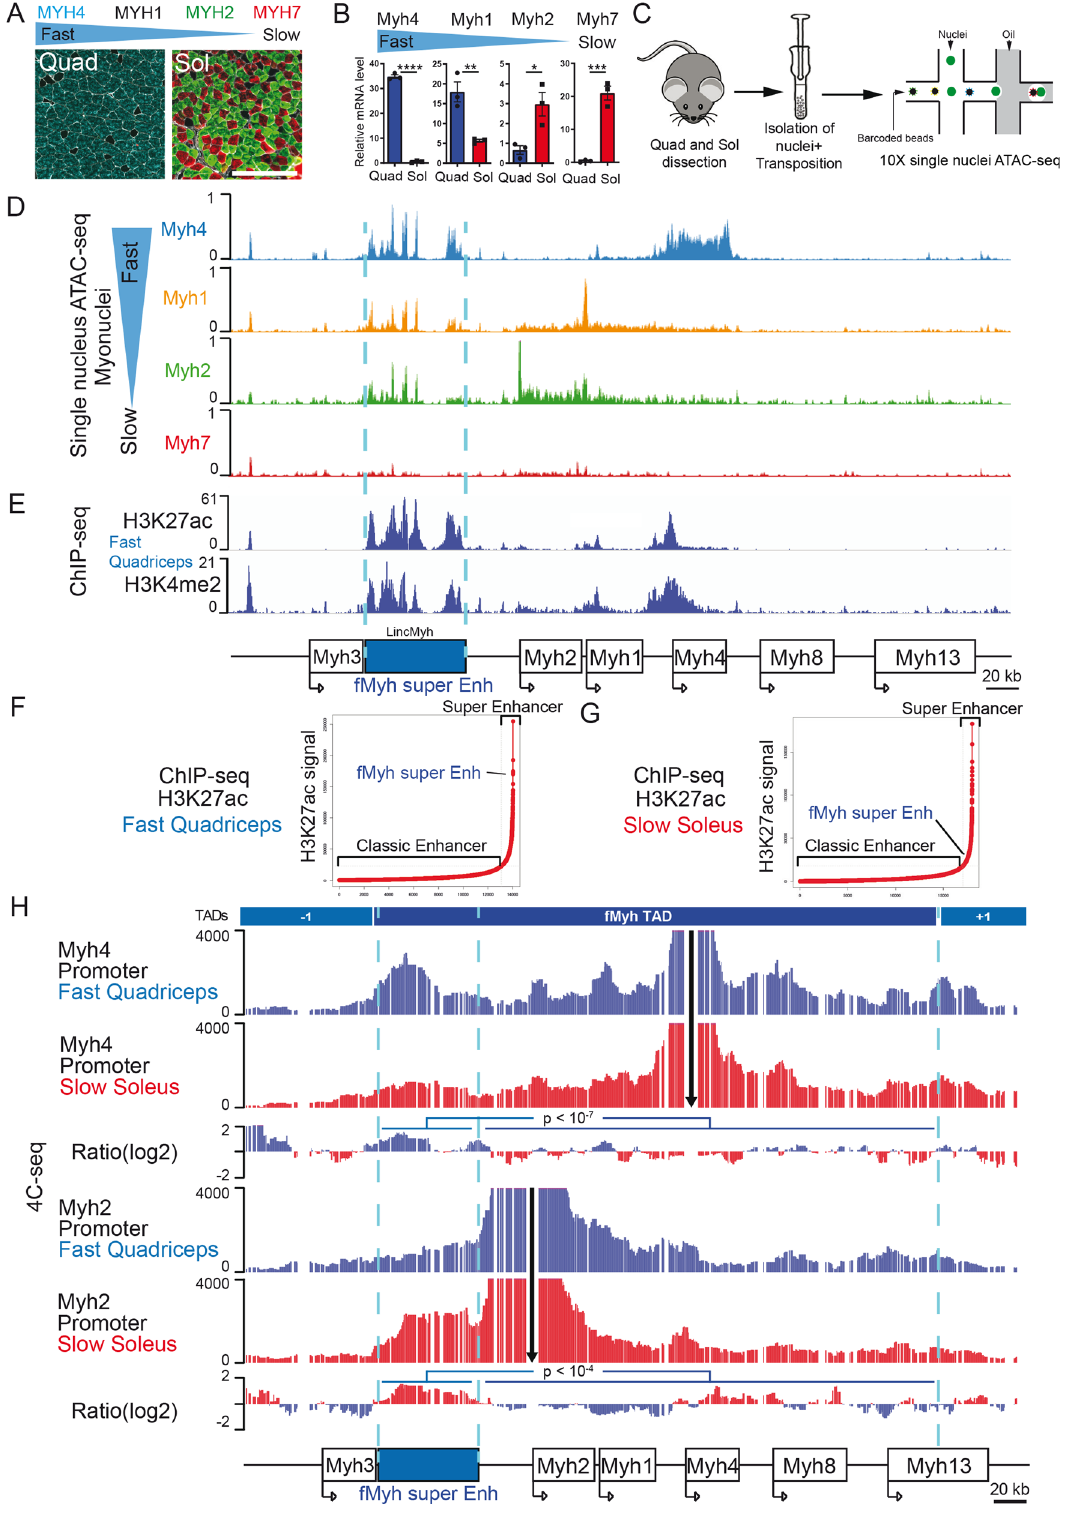
(Fig. S2B). These results show that the fMyh -SE establishes dynamic chromatin interactions with the promoters of the transcribed genes at the locus, with 3D spatial proximity directly coinciding with the activity of the promoters in each fi ber type. The f Myh locus is organized in two topological associated domains . In mammals, interactions between enhancers and